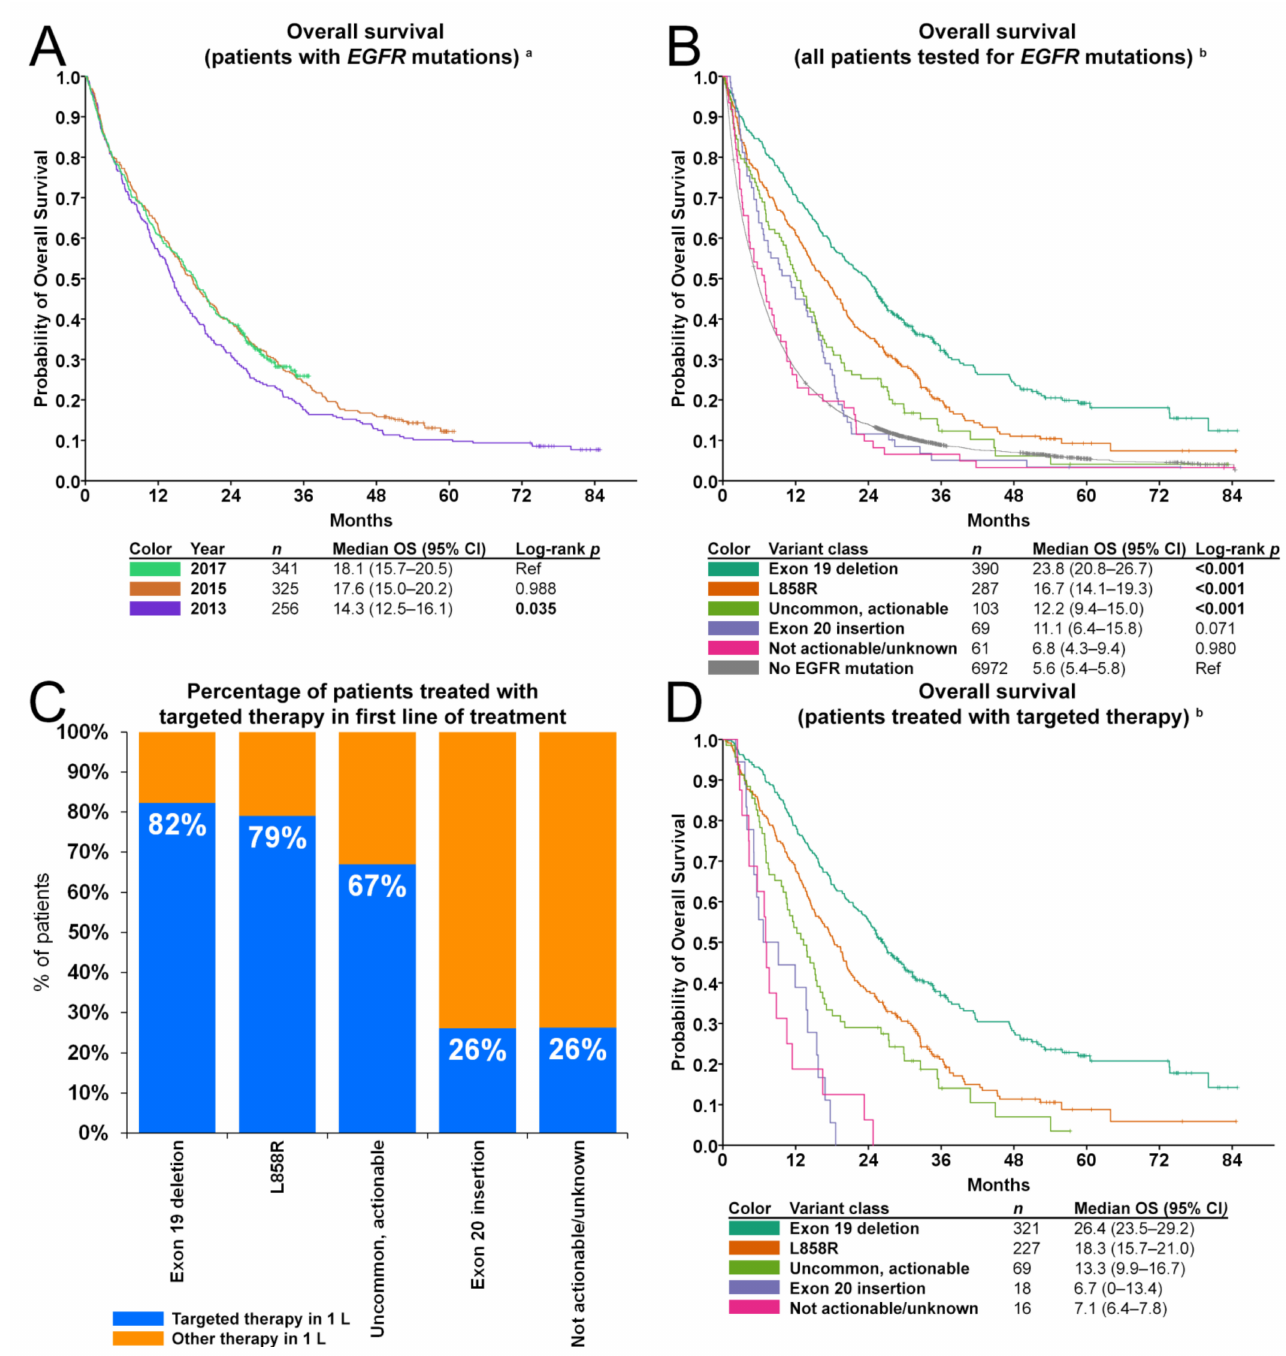
Figure 4. First-line targeted therapy and overall survival. ( A ) Kaplan-Meier curve depicting overall survival by year of diagnosis, irrespective of first-line treatment. Censored cases are indicated with a +. ( B ) Kaplan-Meier curve depicting overall survival by mutation class, irrespective of first-line treatment. Censored cases are indicated with a +. ( C ) Percentage of patients treated with targeted therapy in first-line of treatment, by EGFR mutation class. ( D ) Kaplan-Meier curve depicting overall survival of EGFR -mutant patients treated with targeted therapy in first-line of treatment. Censored cases are indicated with a +. a Excluding patients with missing follow-up data ( n = 3). b Excluding patients with missing follow-up data ( n = 3) and patients reported to have a non-specified EGFR mutation ( n = 12). Abbreviations: 1 L; first-line of treatment; CI, confidence interval; EGFR , epidermal growth factor receptor gene; p, level of significance; OS, overall